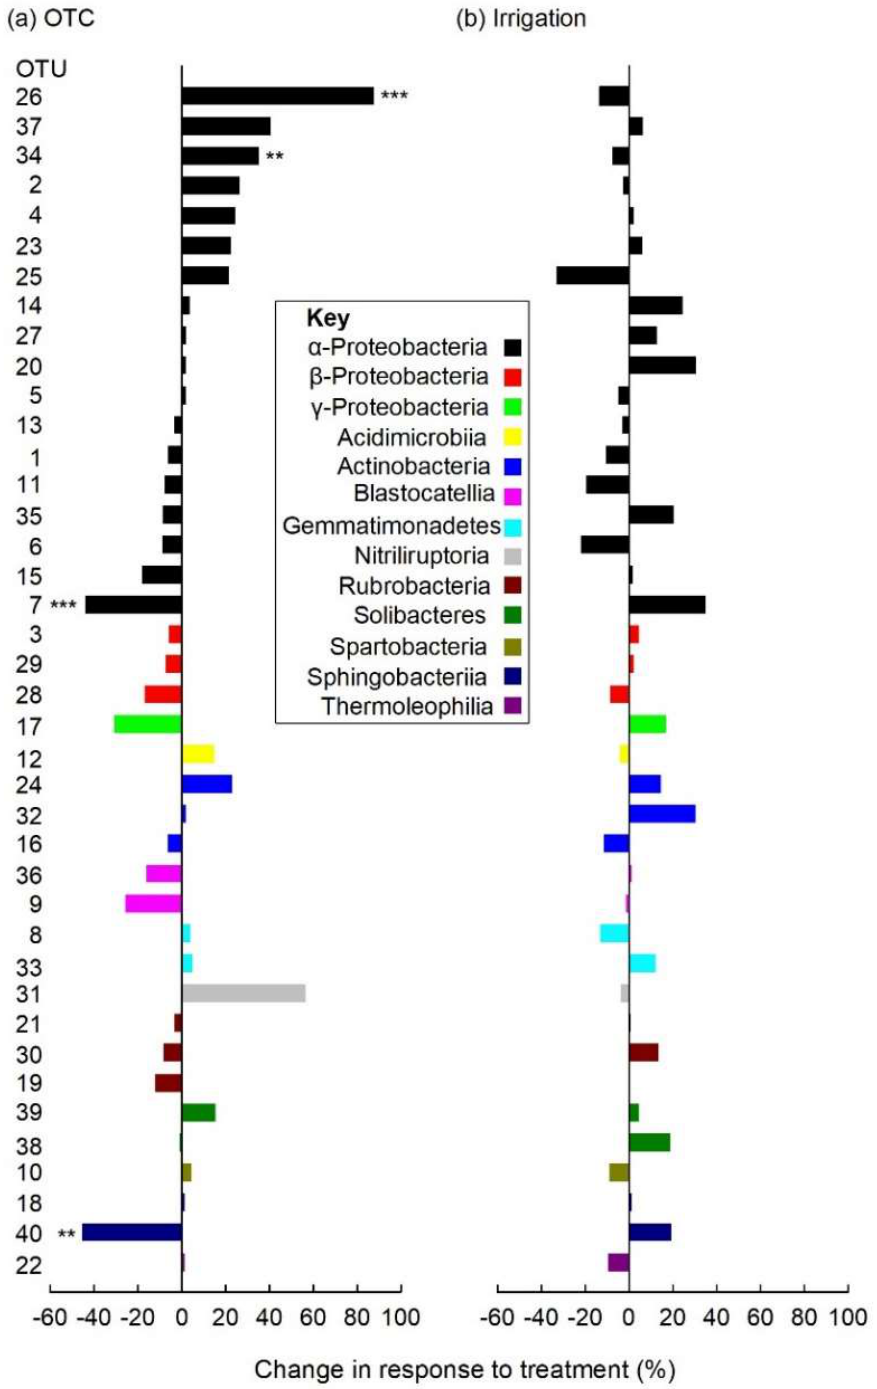
Figure 5. Percentage changes in the relative abundances of the 40 most frequent soil bacterial OTUs in response to the ( a ) OTC and ( b ) irrigation treatments. Values are means of 21–22 replicates. The key shows the classes to which the taxa were assigned at 100% similarity (Table S1). Note that classes are stacked in the same order in the key as they are in the figure, and that x -axes in ( a , b ) are scaled identically. Significant effects of OTCs on the relative abundances of four taxa following Benjamini-Hochberg correction are denoted by ** p < 0.01 and *** p < 0.001.